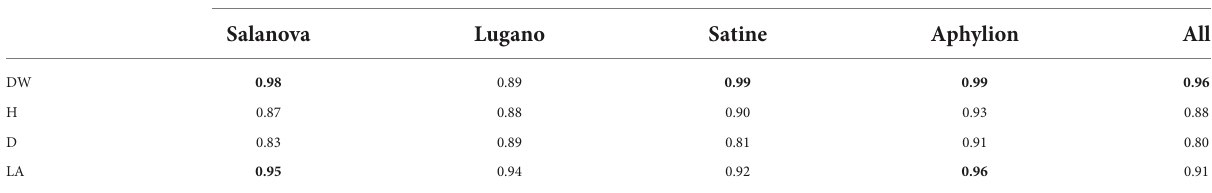
TABLE 1 Correlation between FW and other traits of different lettuce varieties. Traits